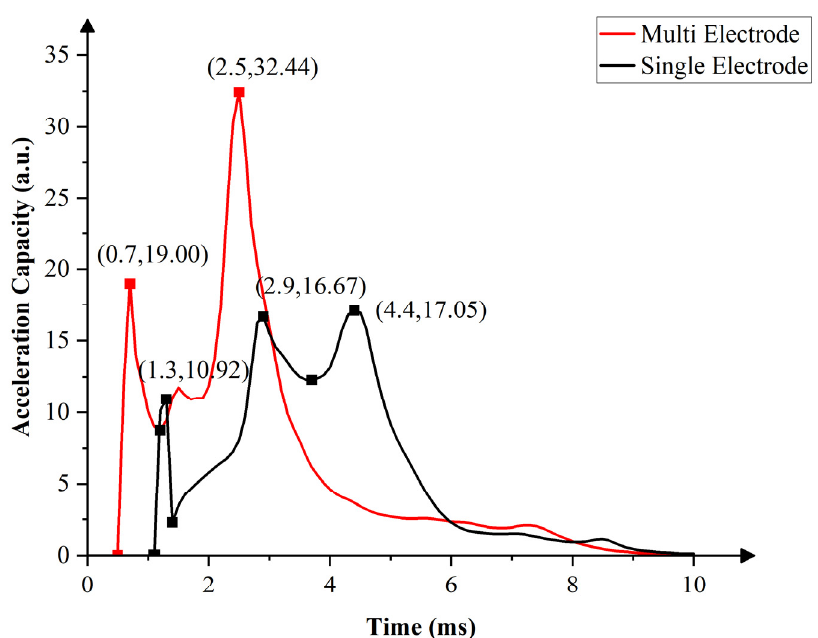
Figure 9. Comparison of oil-acceleration capability between the multi-electrode pixel and the single-electrode pixel. Three accelerations happened to achieve one switching response in the single-electrode pixel, whereas the multi-electrode pixel had two accelerations. For the multi-electrode pixel, peak values at its two accelerations were higher than the single-electrode pixel.